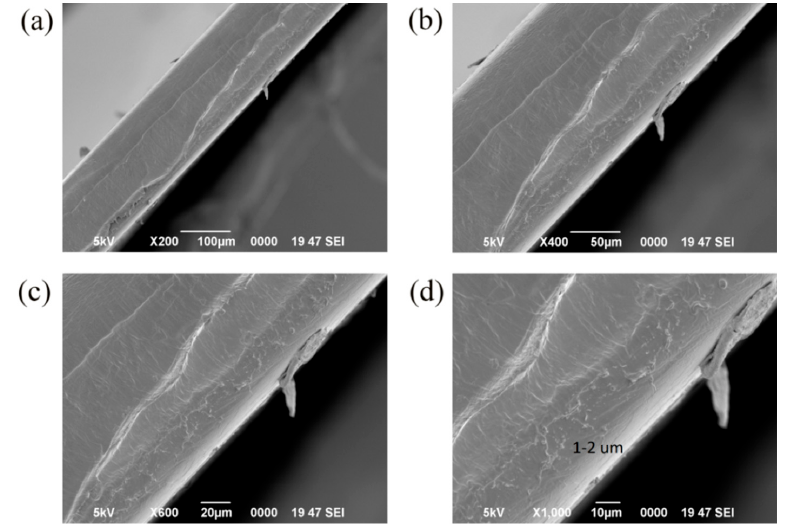
Figure 10. SEM images of 1%S double with different magnifications: ( a ) 200×; ( b ) 400×; ( c ) 600×; and ( d ) 1000×.